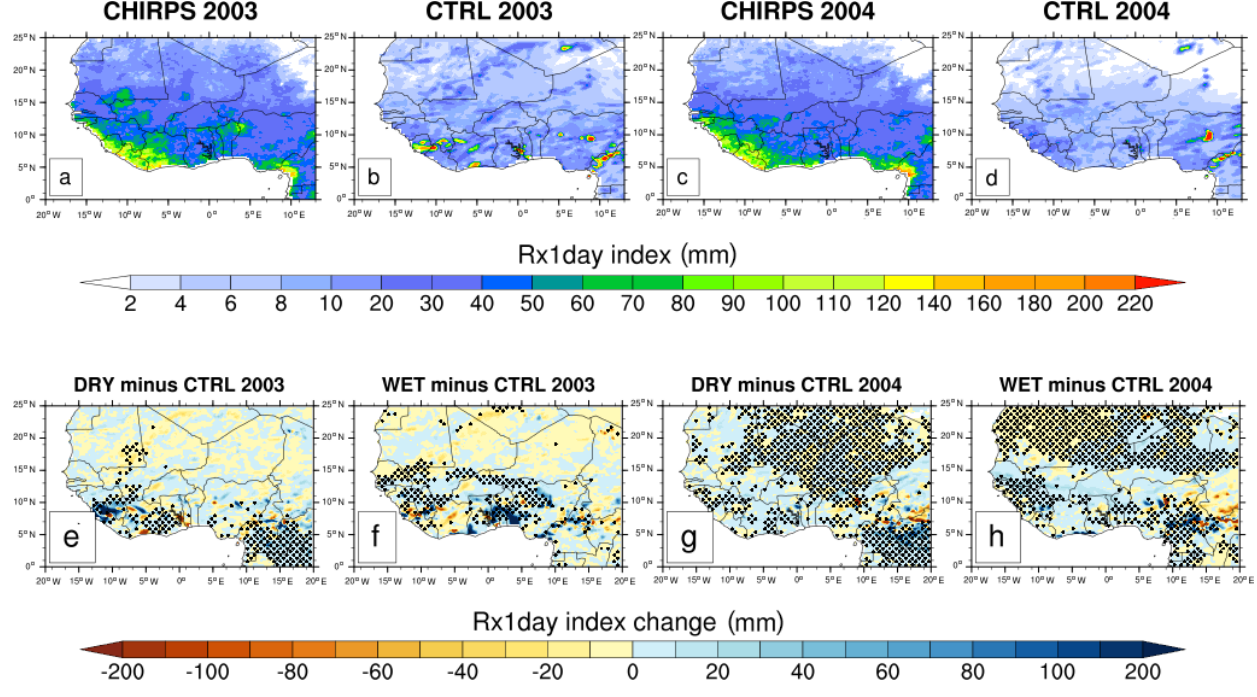
Figure 10. Same as Fig. 2 but for the RX1day index (in